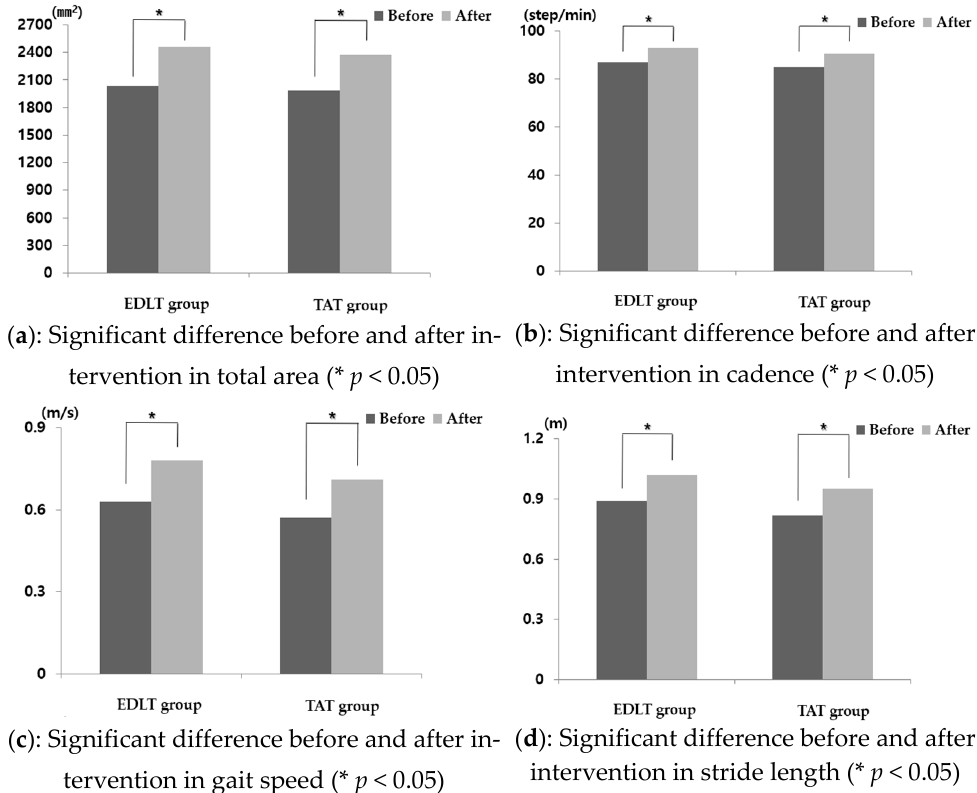
Figure 2. Limited of stability and variables changes are as follows: ( a ) change of total area (mm 2 ); ( b ) change of cadence (step/min); ( c ) change of gait speed (m/s); ( d ) change of stride length (m).